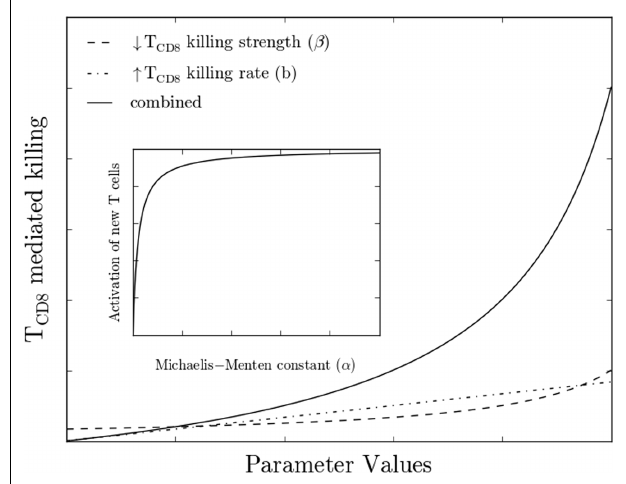
FIGUREA1 |The effect of the variation in the rate constant and the number of tumor cells on theT CD8 mediated killing ofTag-expressing cells. The inset shows the effect of tumor cell numbers on the activation of